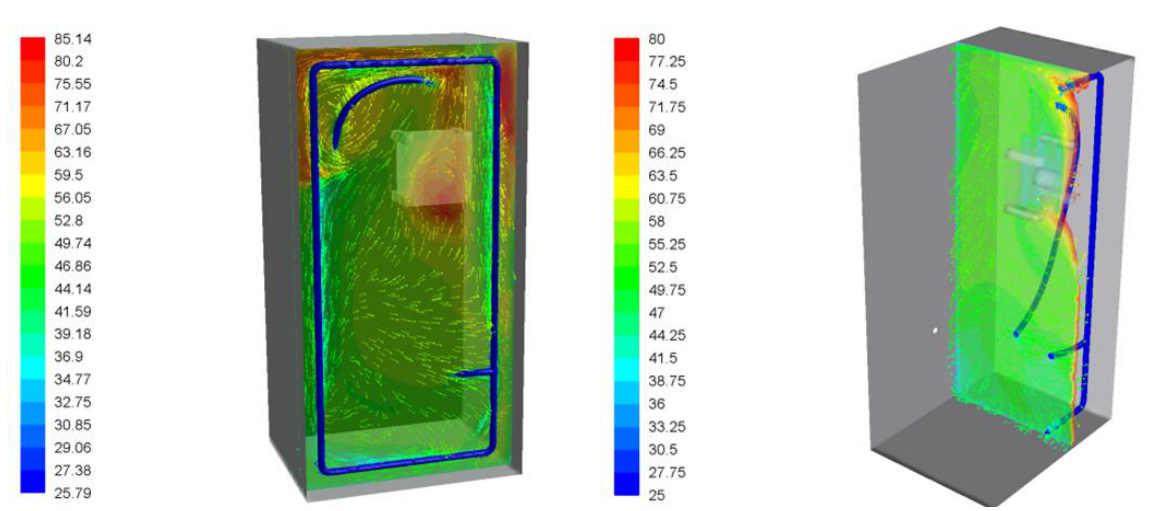
Figure 9. Temperature of the air flux inside the box